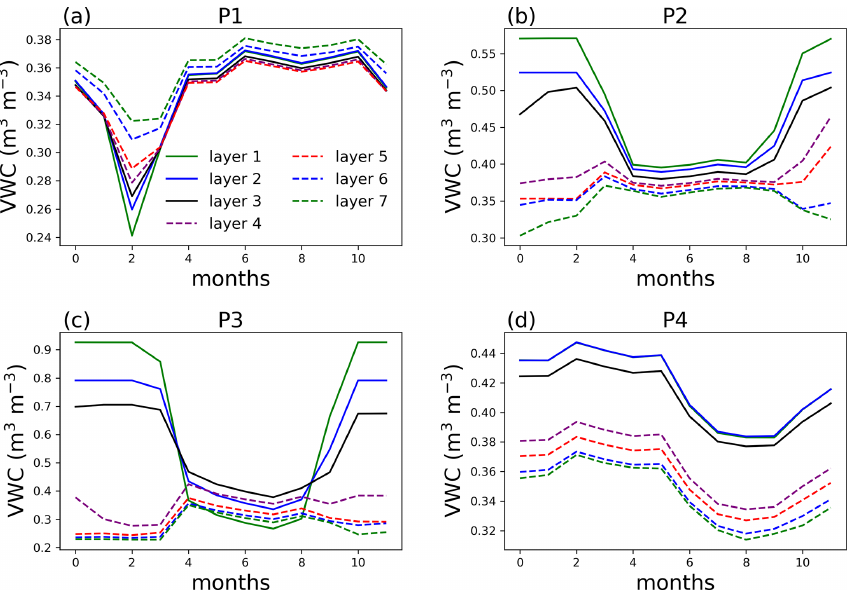
Figure 8. Volumetric water content (VWC) at selected points for single-point simulations at year 100 of the simulation with no layer aggregation.